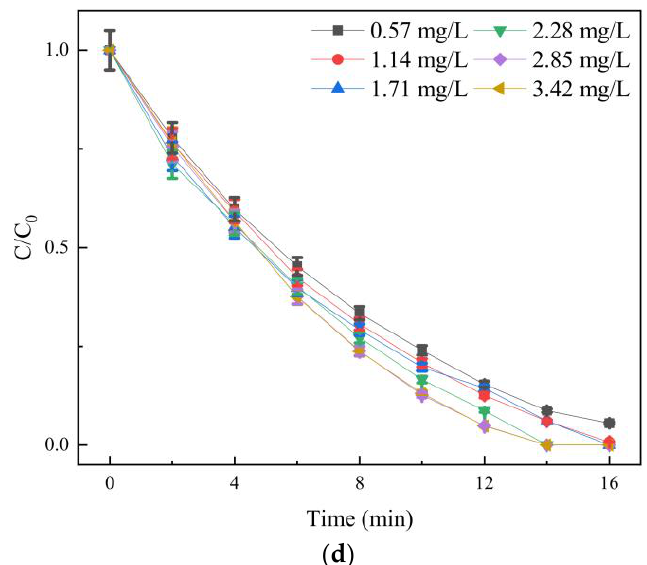
Figure 5. The effects of different oxidant dosages on SDZ degradation in O 3 , O 3 /UV, and O 3 /PMS processes (reaction conditions: SDZ = 10 mg/L, O 3 = 3 mg/L, UV = 0.9 mw/cm 2 , T = 25 ± 0.5 °C, pH = 6.8 ± 0.1; ( a – c ) O 3 = 1, 2, 3, 4, 5, 6 mg/L; ( c ) PMS = 22.8 mg/L; ( d ) PMS = 5.7, 11.4, 17.1, 22.8, 28.5, 34.2 mg/L, O 3 = 3 mg/L). ( a ) Ozone dosage in O 3 , ( b ) Ozone dosage in O 3 /UV, ( c ) Ozone dosage in O 3 /PMS, ( d ) PMS dosage in O 3 /PMS. Table 4. Pseudo-first-order rate constants of O 3 , O 3 /UV, and O 3 /PMS under different ozone dosage conditions (reaction conditions: SDZ = 10 mg/L, O 3 = 3 mg/L, UV = 0.9 mw/cm 2 , T = 25 ± 0.5 °C, pH = 6.8 ± 0.1, O 3 = 1, 2, 3, 4, 5, 6 mg/L; PMS = 22.8 mg/L).